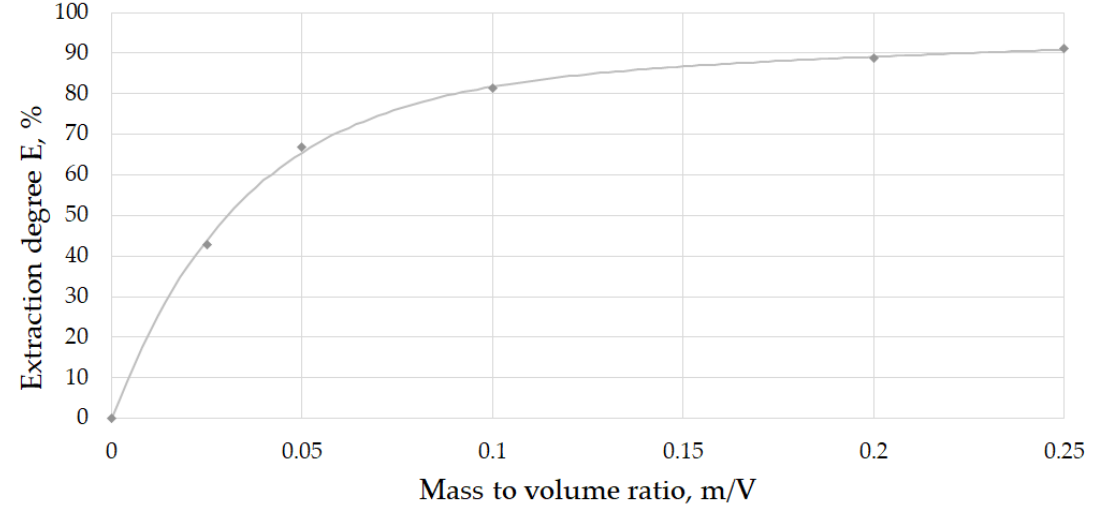
Figure 12. The dependence of yttrium extraction degree on a solid and liquid phase ratio (g / mL).